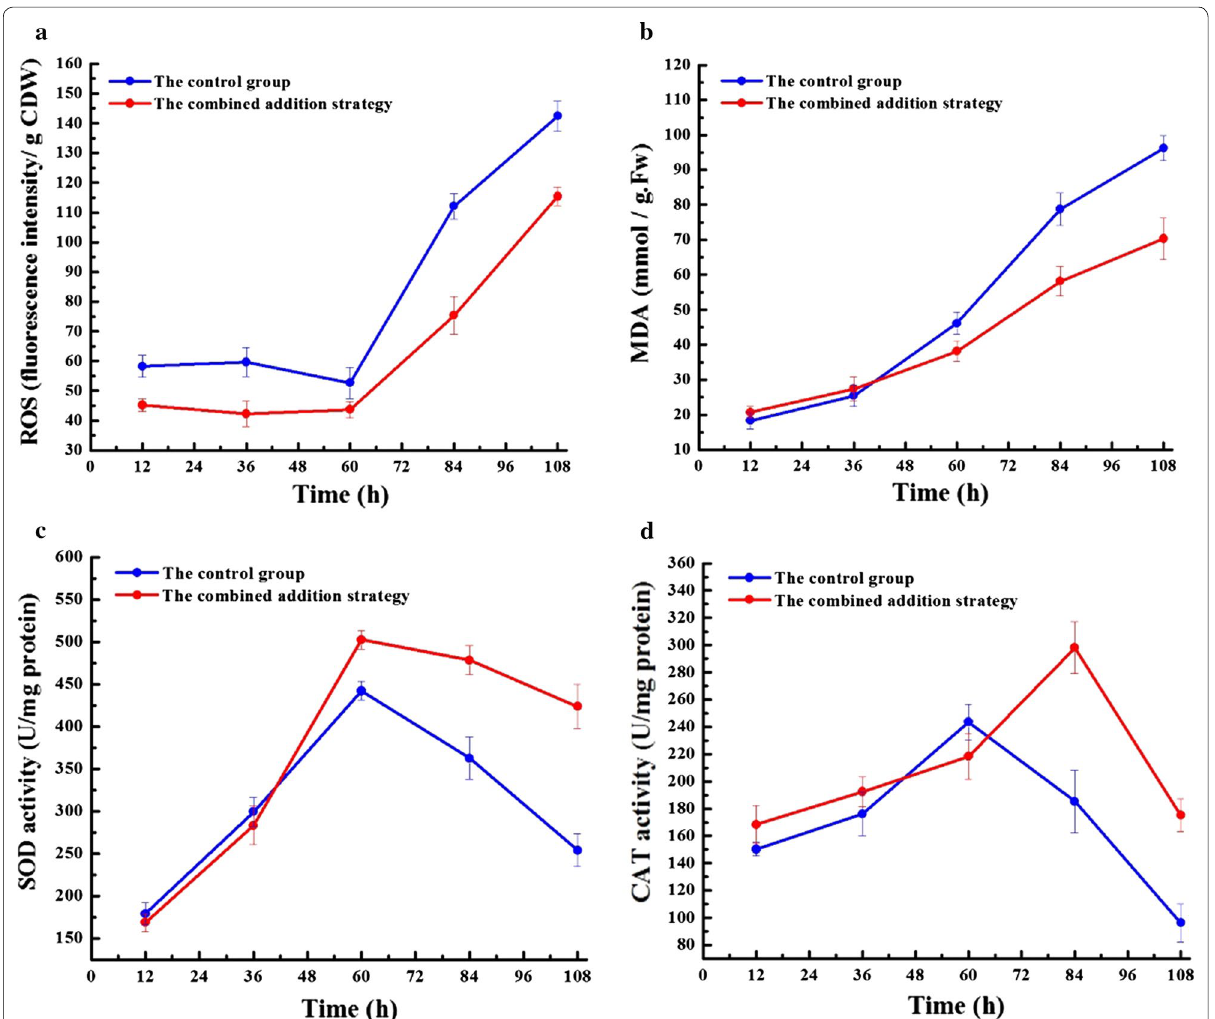
Fig. 2 Comparison of anti‑oxidative defense system between the control group and the combined addition strategy in a 5‑L bioreactor: a ROS levels, b MDA levels, c SOD activity, d CAT activity. Values and error bars represent the means and standard deviations from triplicate